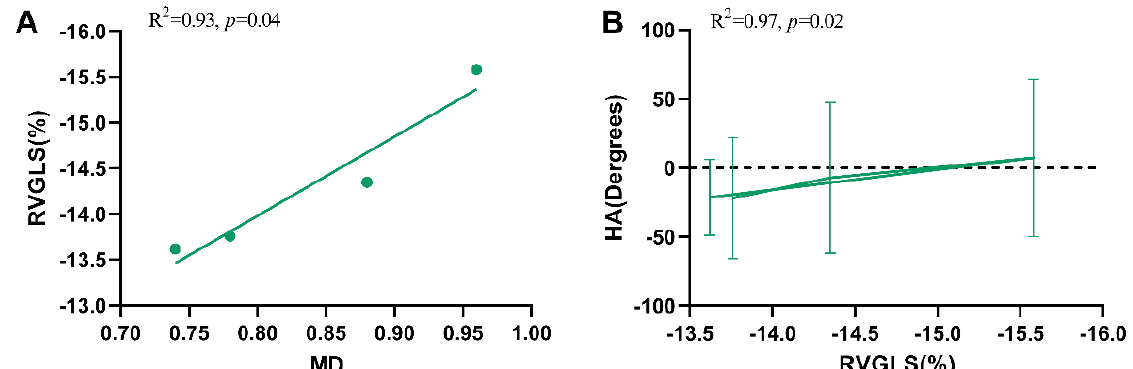
Figure 6. ( A ) Correlation between MD and RVGLS (%) in HLHS fetuses. ( B ) Correlation between HA degrees of the right ventricle basal lateral wall and RVGLS (%) in HLHS fetuses. The measurements of myocardial deformation all showed excellent reproducibility.